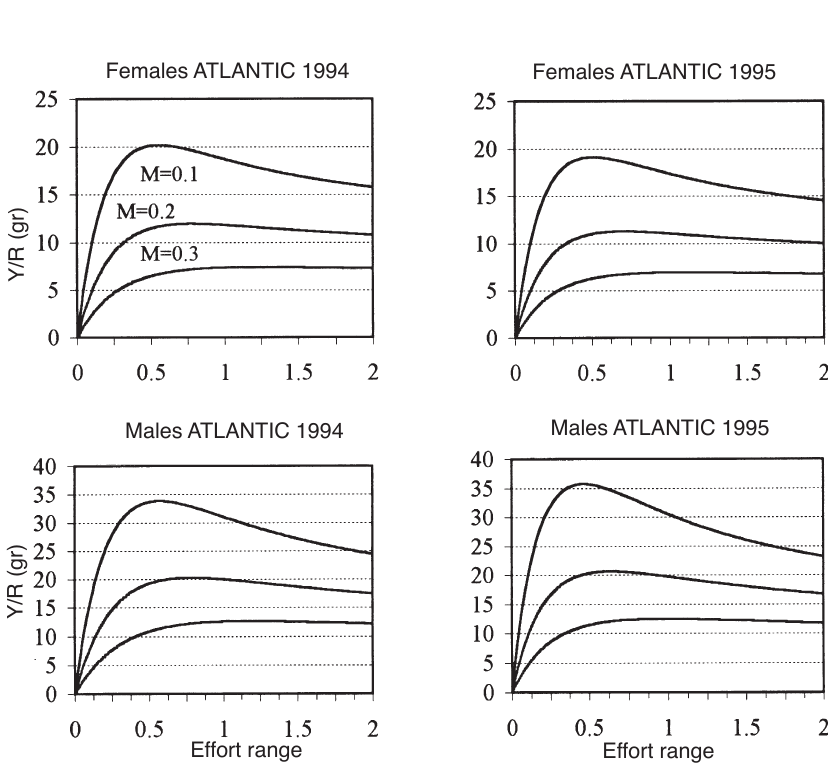
F IG . 3. - Atlantic yield per recruit